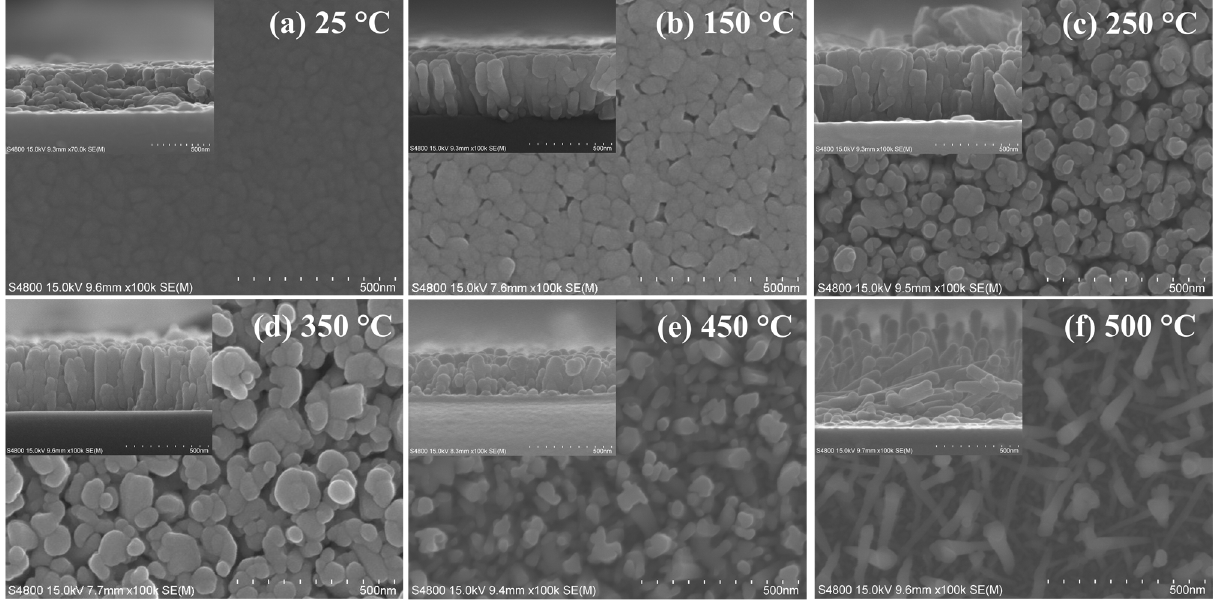
Figure 2. Surface morphology and cross-sectional FESEM images of CdS thin films at ( a ) T s = 25 °C, ( b ) T s = 150 °C, ( c ) T s = 250 °C, ( d ) T s = 350 °C, ( e ) T s = 450 °C and ( f ) T s = 500 °C.